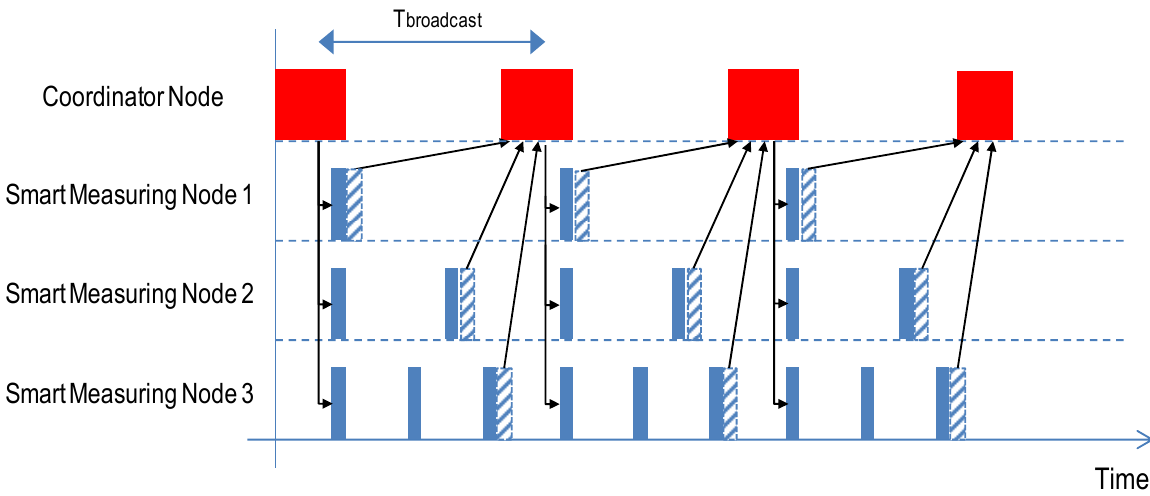
Figure 10. Scenario 2: combination of several SMNs using different sampling configurations.